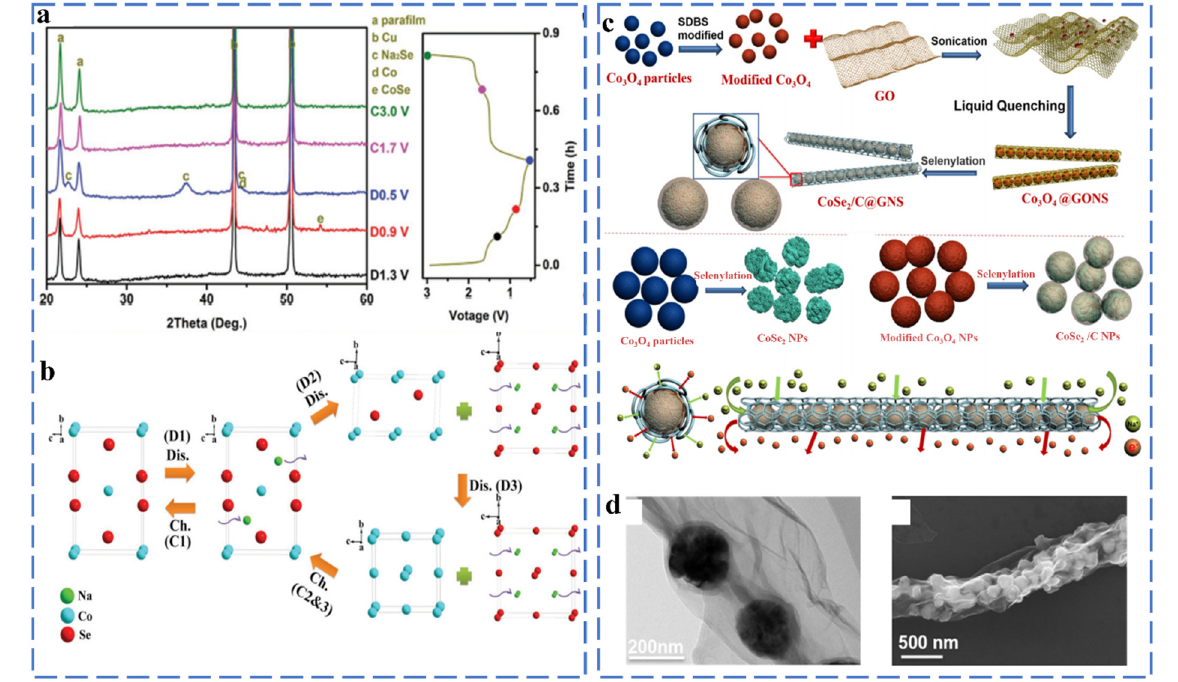
Figure 4. ( a ) Ex situ XRD patterns of the CoSe 2 at various discharging/charging states. ( b ) Schematic illustration of reaction mechanism of CoSe 2 when cycling between 0.5 and 3.0 V and using ether- based electrolytes. Reprinted with permission from Ref. [43]. Copyright 2016, copyright Zhang, K. ( c ) Schematic illustration of the fabrication of CoSe 2 /C@GNS, ( d ) SEM and TEM images. Reprinted with permission from Ref. [44]. Copyright 2016, copyright Zhang, Z .